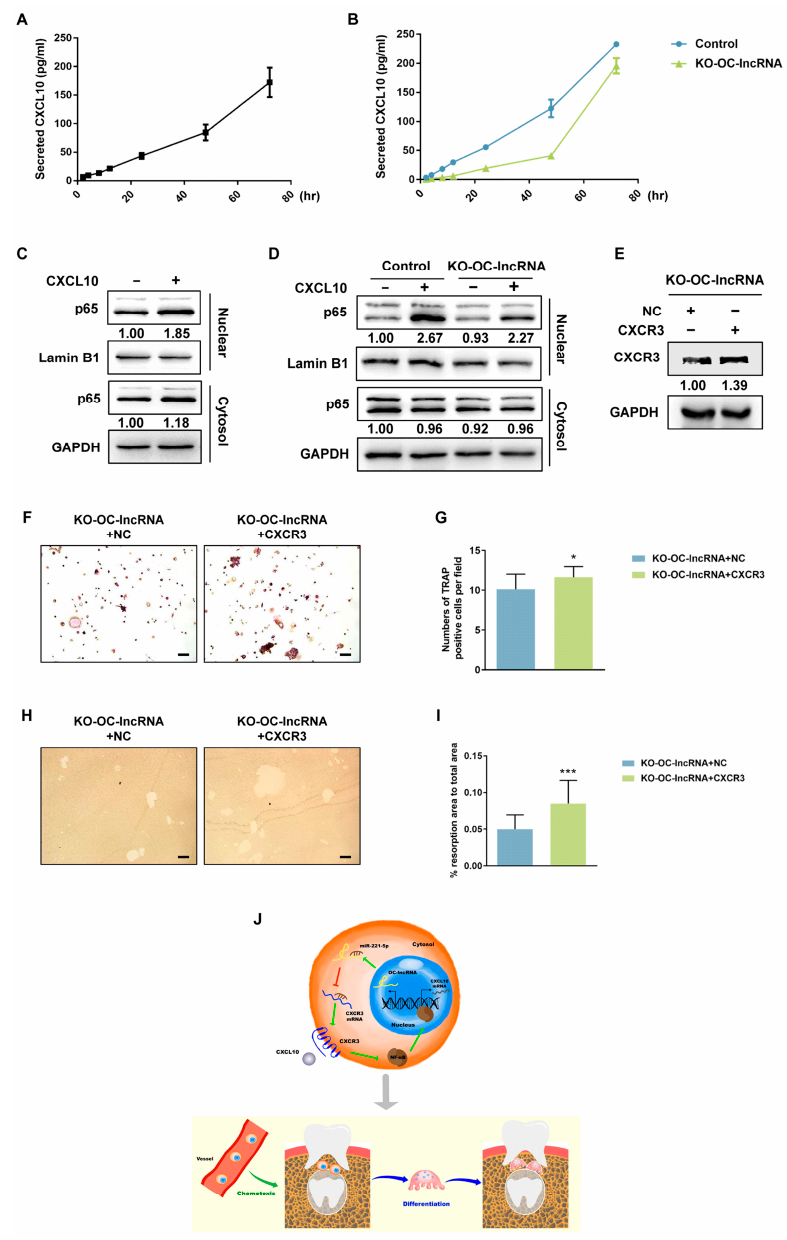
2 Figure 7. CXCL10–CXCR3 promoted osteoclast differentiation and bone resorption by